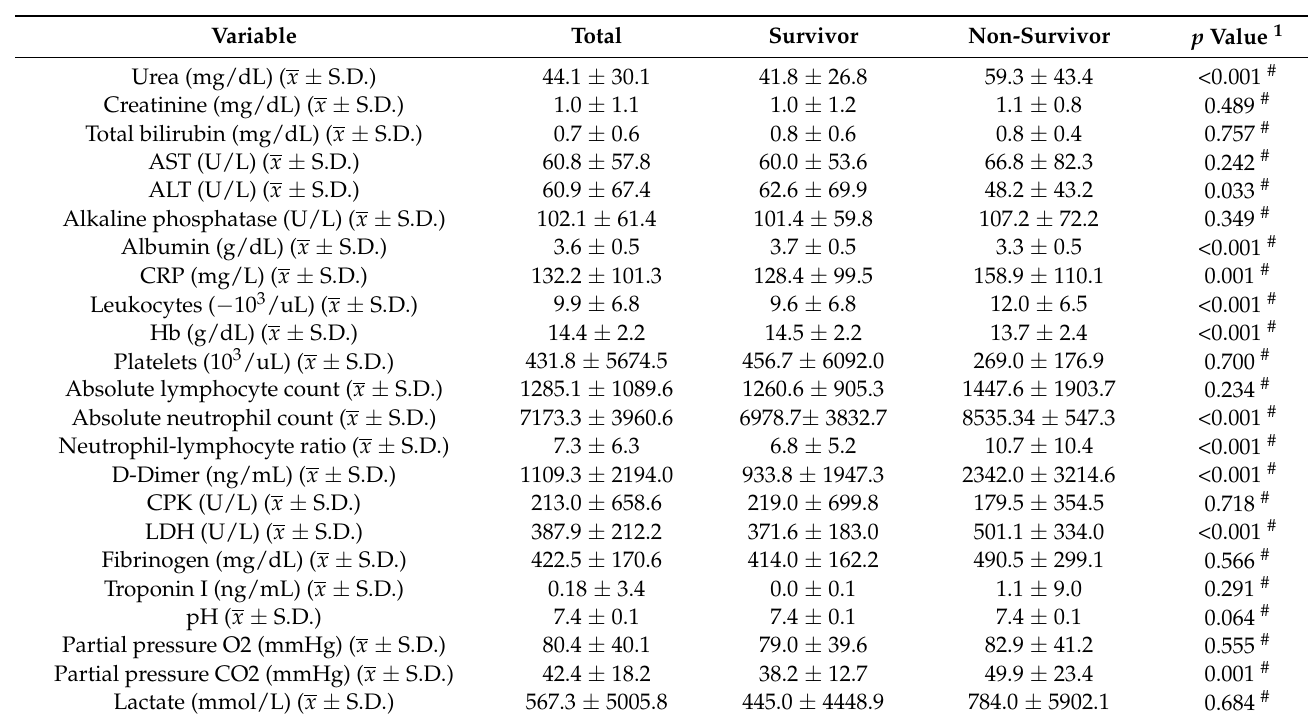
Table 3. Comparisons of laboratory findings between non-survivors and survivors at